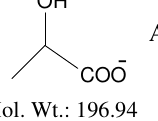
Figure 1 . Chemical structure of silver